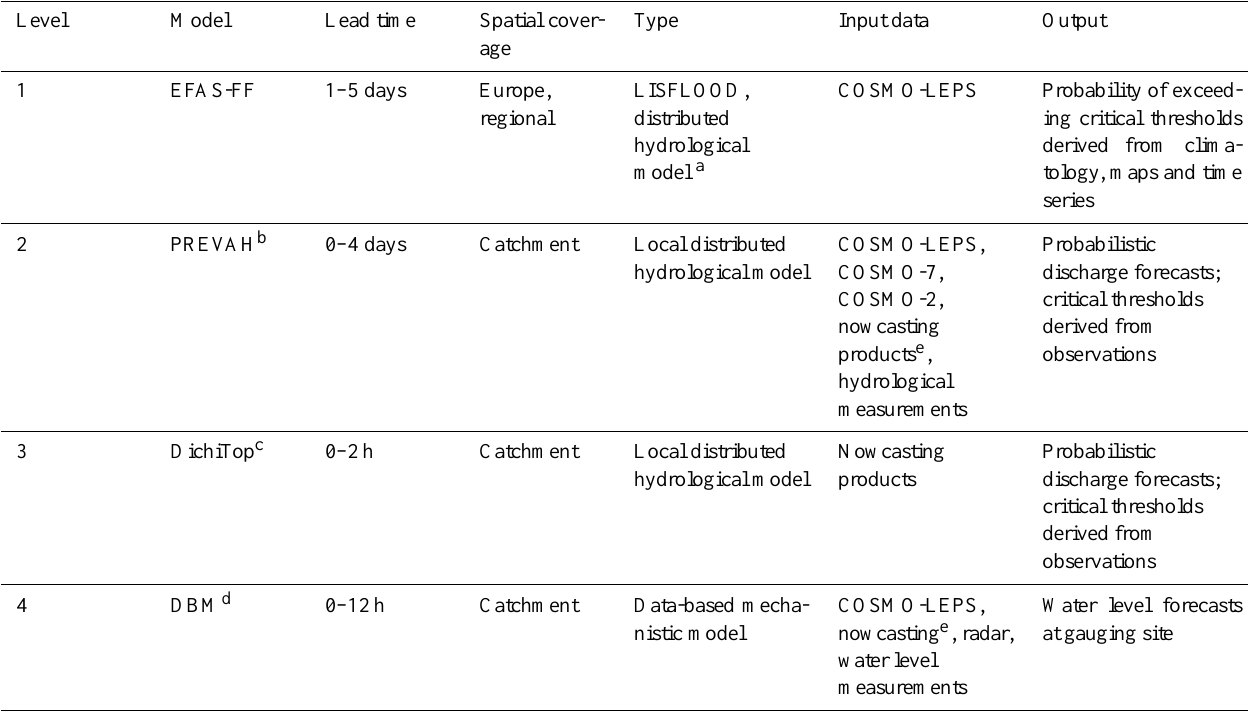
Table 1. Hydrological models applied in the IMPRINTS project as well as their spatial and temporal target areas, inputs and outputs within the